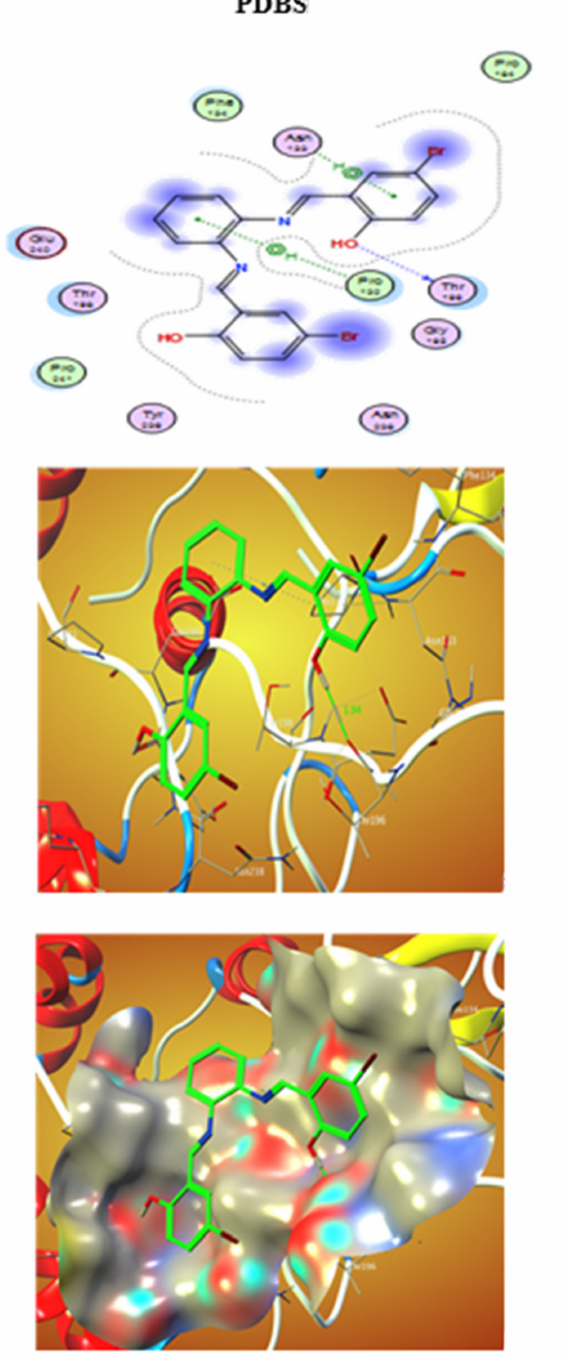
Figure 11. 2D and 3D plots of the interaction between PDBS and [FePDBS(H 2 O)NO 3 ] with the active site of the receptor of viral protein (PDB ID: 6lu7). Dotted curves depict hydrophobic interactions with amino acid